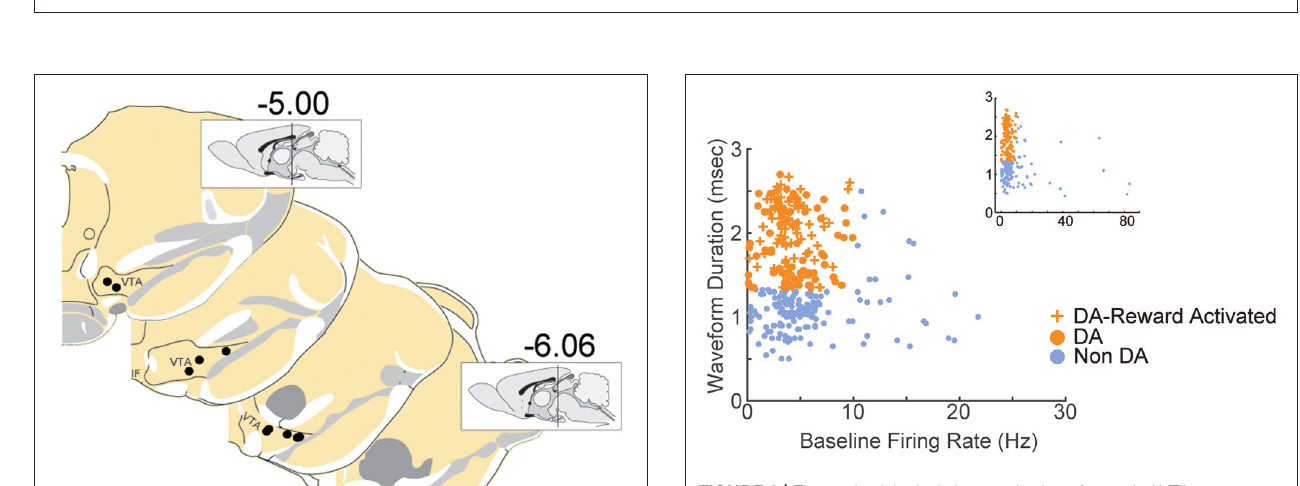
FIGURE 3 | Electrophysiological characterization of recorded VTA neurons. Each point represents a single neuron; data from all sessions are depicted. Neurons with wide spike widths ( > 1.4 ms) and low firing rates ( < 10 Hz) were considered putative dopamine neurons. Crosses depict reward-responsive dopamine neurons. The remaining neurons were considered putative non-dopamine neurons. The main figure depicts the data with the horizontal axis limited to 30, for better visualization of the majority of the data. Inset shows the same data, with the horizontal axis extended to encompass the full range of baseline firing